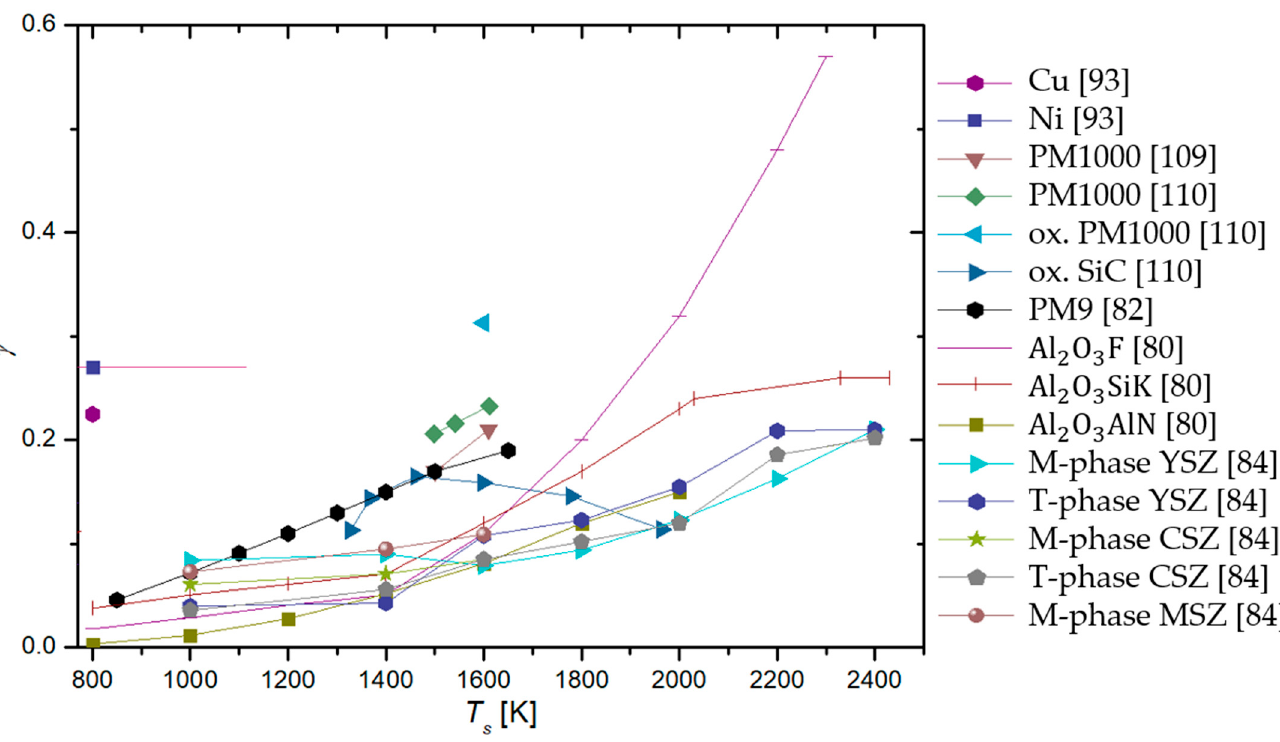
Figure 17. Recombination coefficient ( γ ) of neutral oxygen atoms versus surface temperature ( T s ) for various catalytic surfaces at temperatures higher than 800 K.